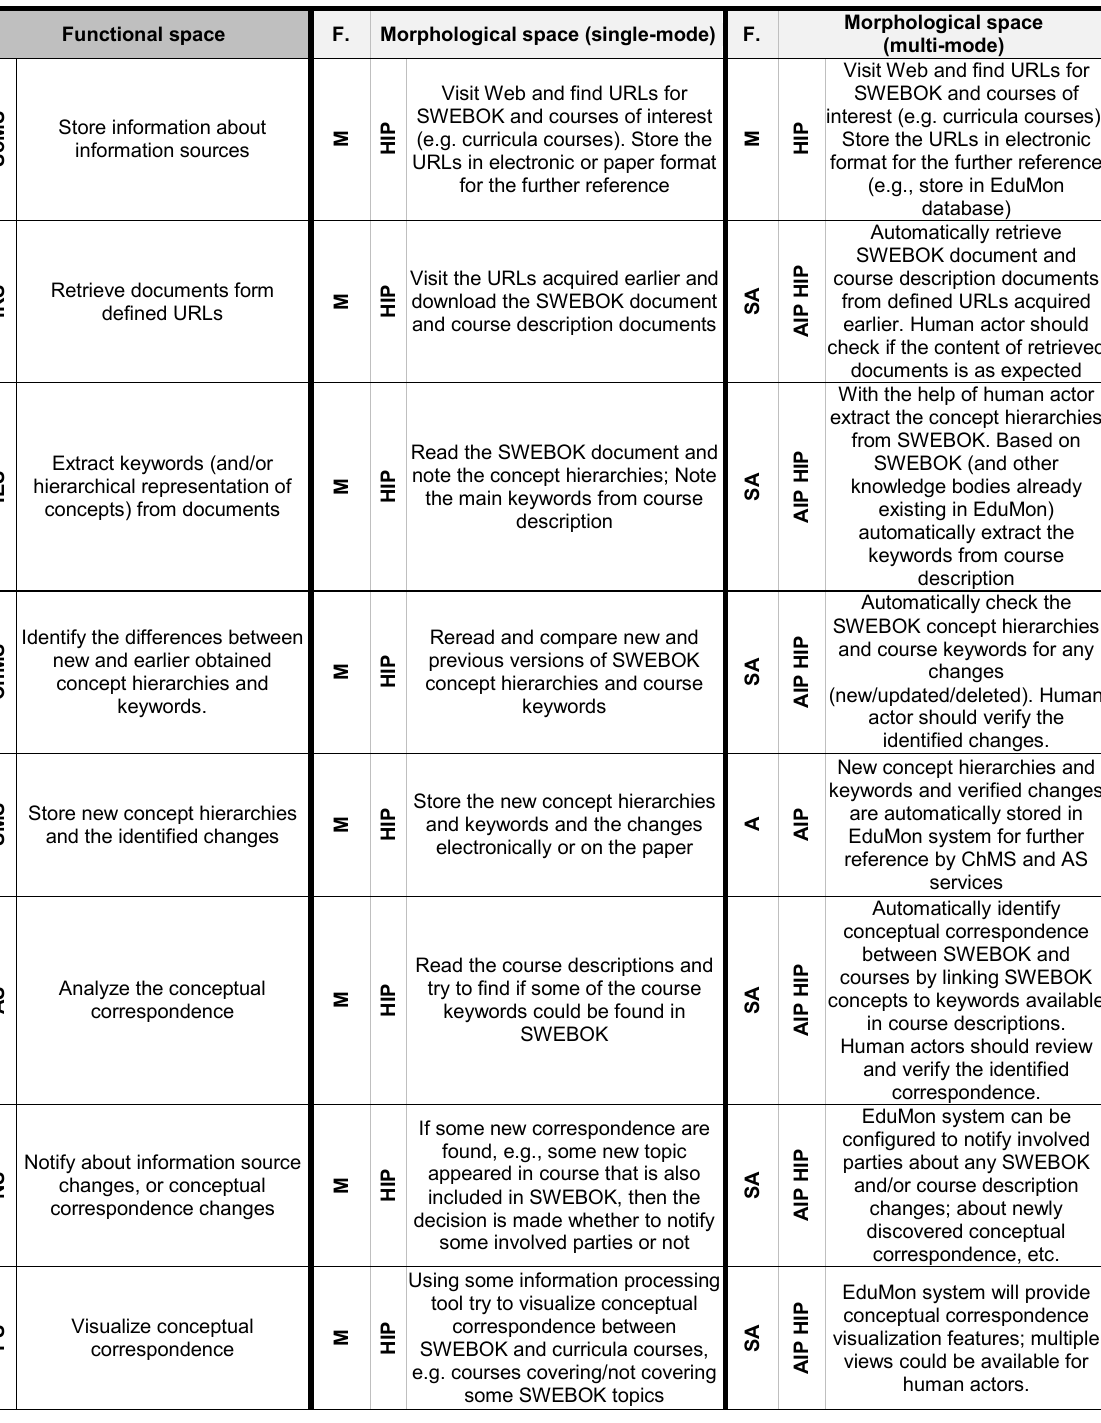
Table 3. Example of the scenarios of internal information logistics of monitoring node in case of monitoring the conceptual correspondence between SWEBOK and curricula courses Functional